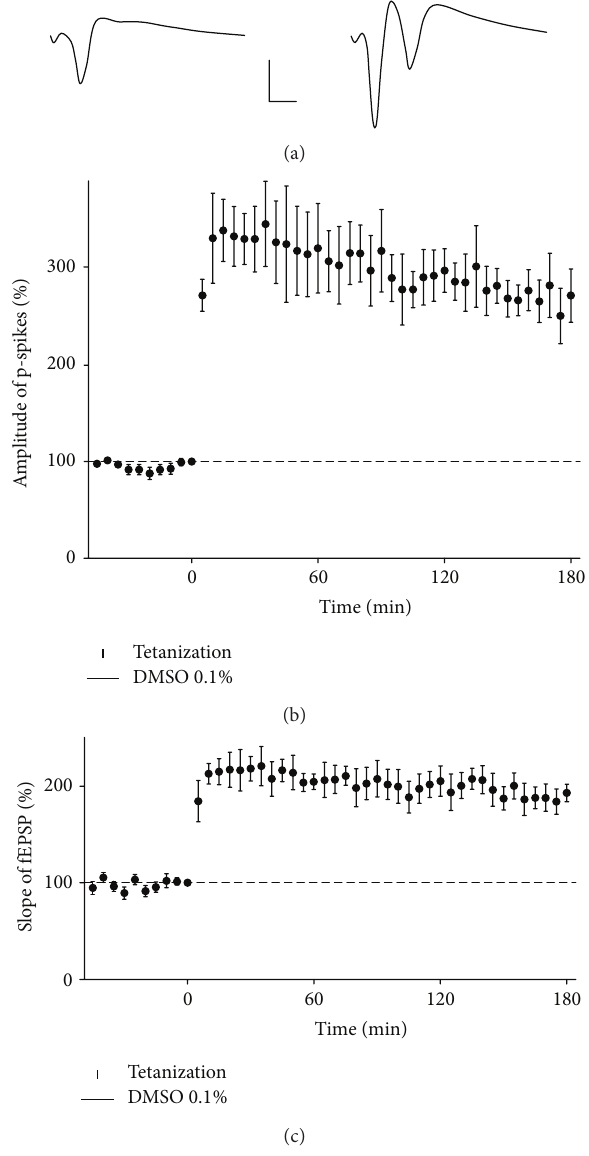
Figure 1: Long-term potentiation in the rat hippocampal CA1 area. (a) Representative responses to test stimuli before tetanization (left) and 30 min after tetanization (right). Calibration bars: 3 ms, 1mV. (b, c) Abscissa, the time from the onset of tetanization. Ordinate, the amplitude of p-spikes (b) or the slope of field excitatory postsynaptic potentials (c), which is normalized to the amplitude of the response to the stimulus that immediately preceded tetanization. The data are the mean ± S.E.M. ( 𝑛 = 4